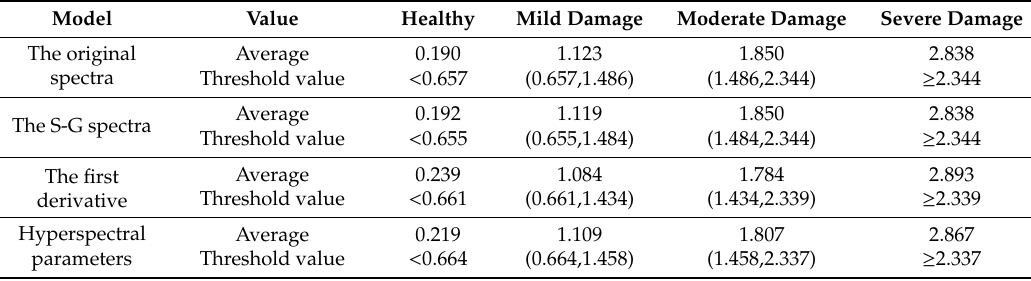
Figure 11. Linear fitting of the measured and predicted values. ( a ) The original spectral model. ( b ) The S-G spectral model. ( c ) The model of the first derivative. ( d ) The model of hyperspectral parameters. Table 11. Quantitative discriminant rules of the damage degree of Yunnan pine canopy caused by PSB ( n = 56). The threshold value was determined based on the median of the average values of the two degrees of